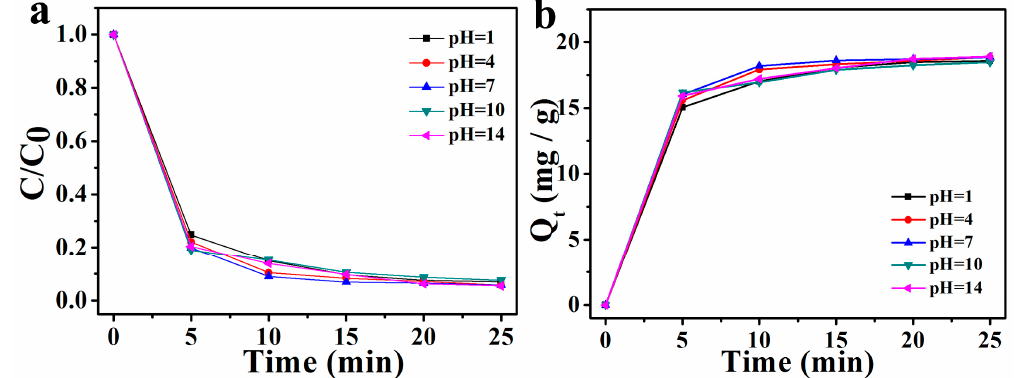
Figure 10. ( a ) Changes of the relative concentrations of MB aqueous solutions, added by the CCT-BFO adsorbent, versus time under different initial pH values; ( b ) Changes of the adsorption capacities of the CCT-BFO adsorbent versus time under different pH values. The MB initial concentration is 10 mg·L − 1 .